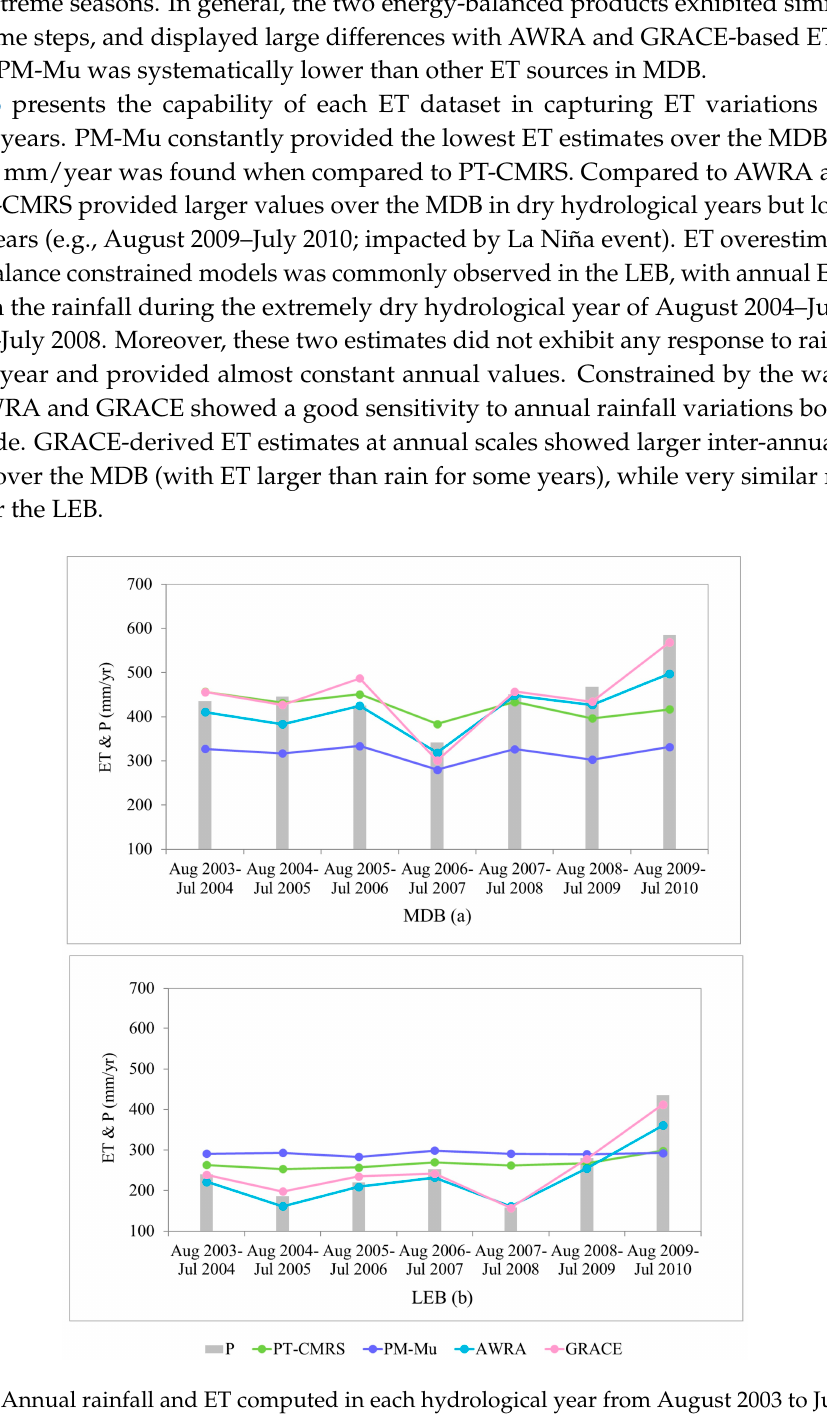
Figure 6. Annual rainfall and ET computed in each hydrological year from August 2003 to July 2010 for the MDB ( a ) and the LEB ( b ).